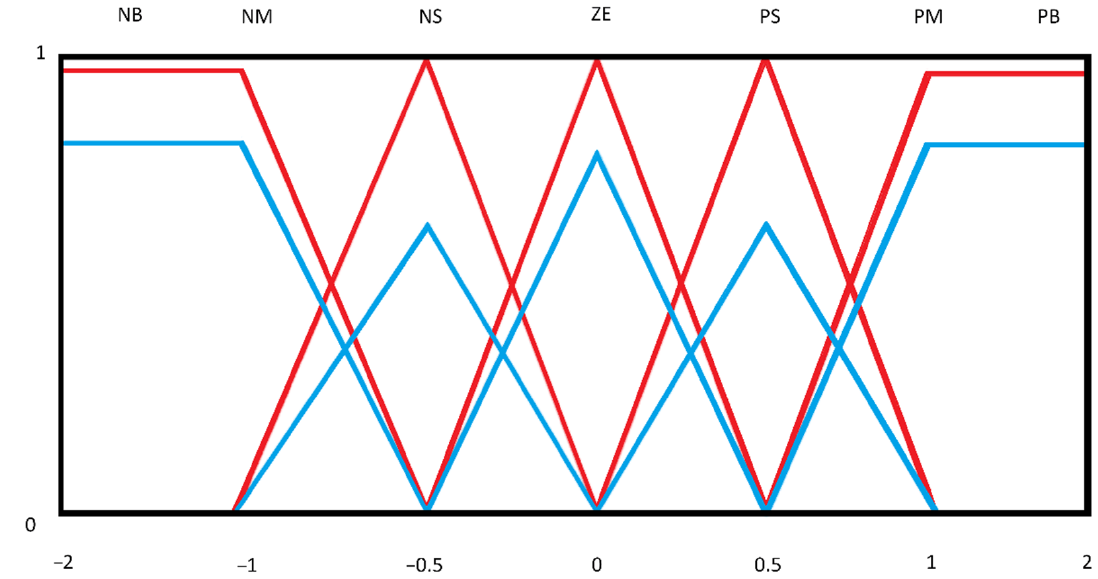
Figure 10. Fuzzy Type-2 primary membership function of error and error deviation.